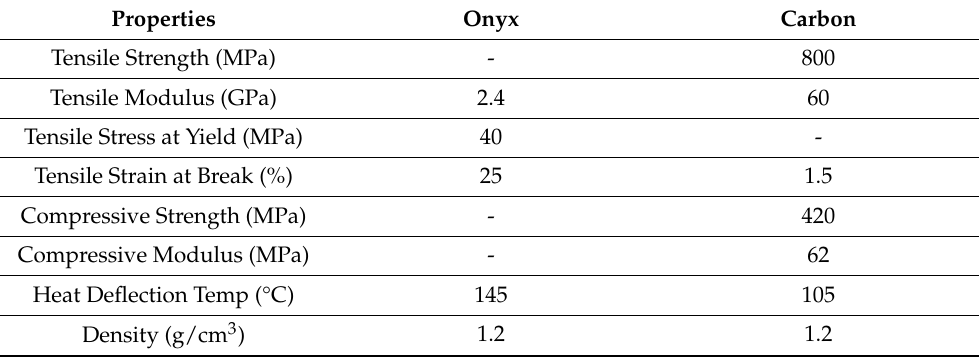
Table 4. Onyx and Carbon material composites.